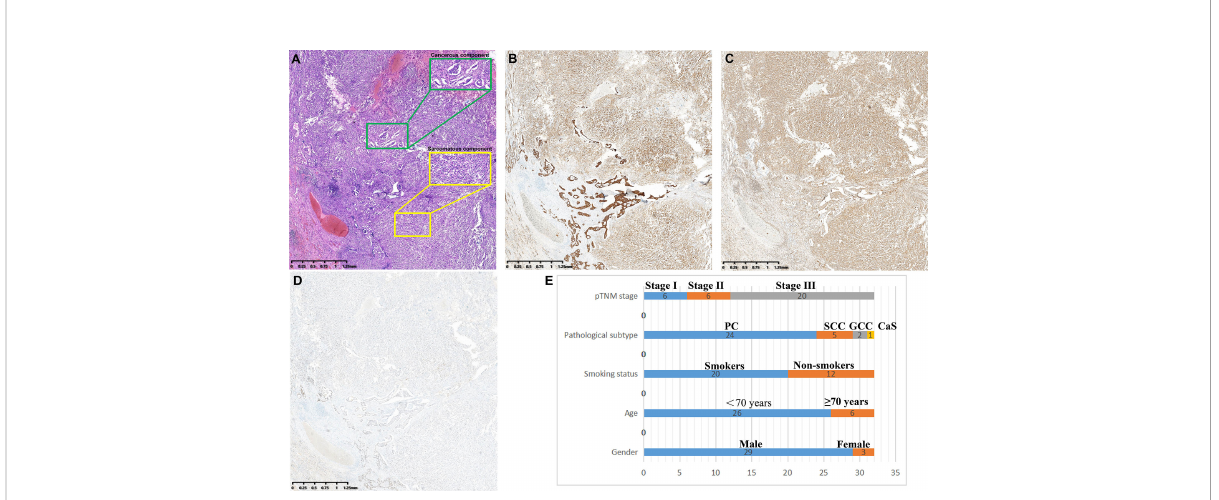
FIGURE 2 Clinicopathological features of PSCs. (A) Spindle cells with atypia mixed with adenocarcinoma components. (B) pan-CK was positive in both sarcoma and carcinoma components. (C) Vimentin is speci fi cally expressed in sarcoma components but not in cancerous components. (D) TTF-1 was strongly positive in the adenocarcinoma component and weakly positive in the sarcoma component. (E) Subtype distribution of PSCs.